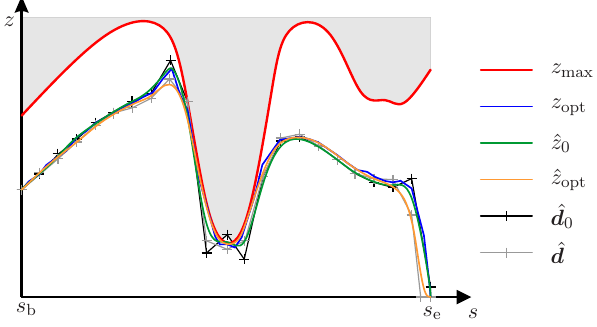
Figure 6. Spline approximation and optimal